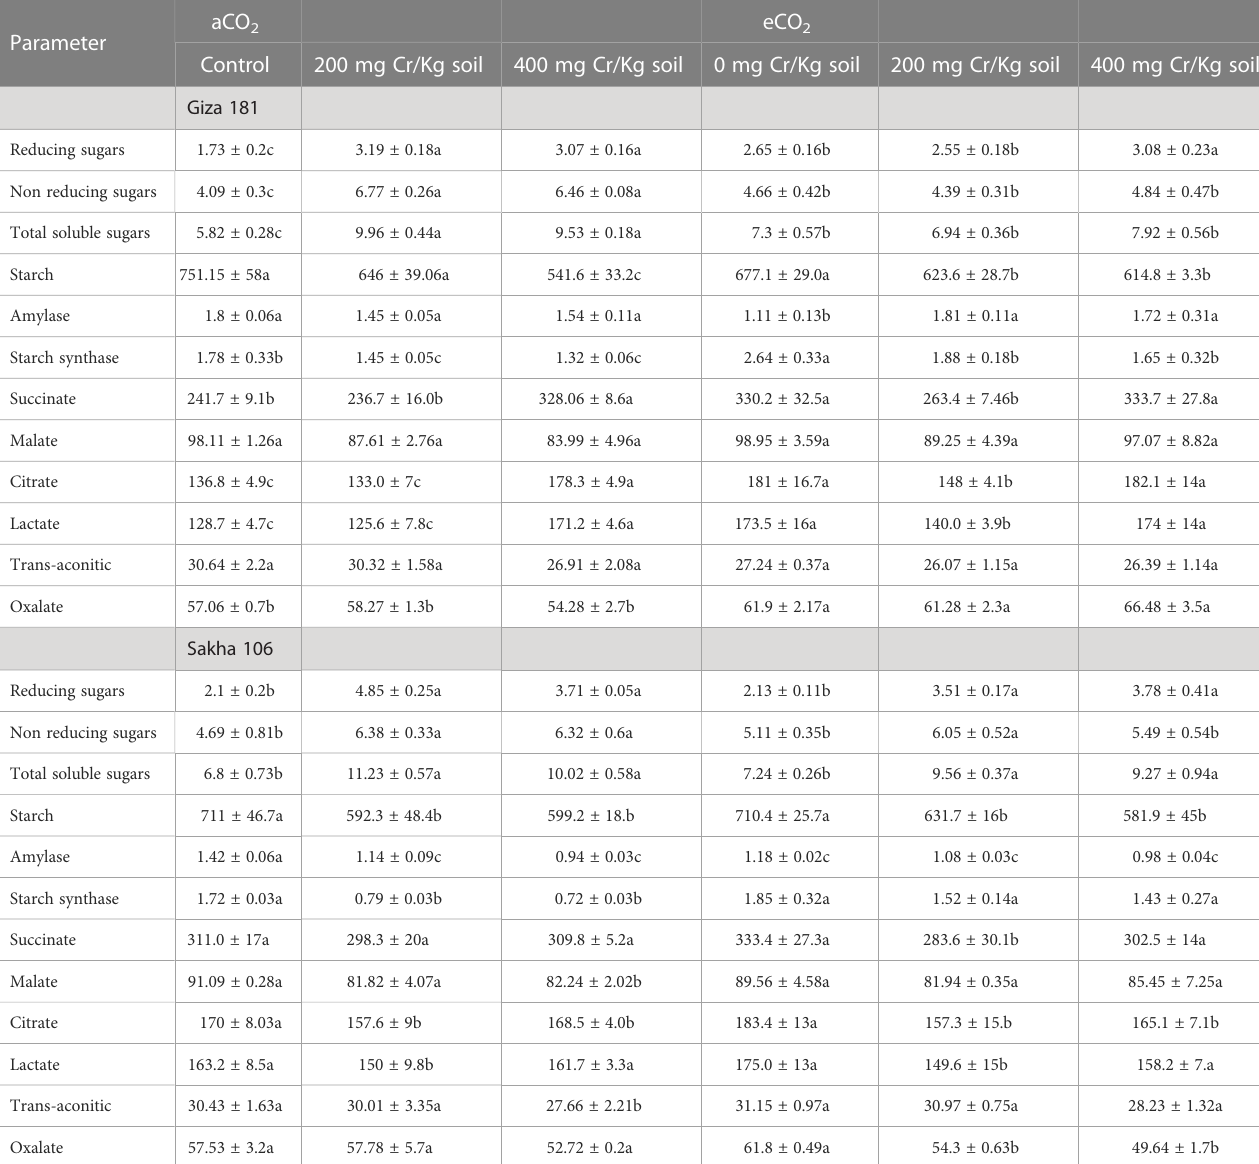
TABLE 2 Effect of Chromium (Cr) exposure on the levels of sugars and organic acids and the activities of sugar metabolizing enzymes in rice grains produced under either aCO 2 (410 ppm) or eCO 2 (620